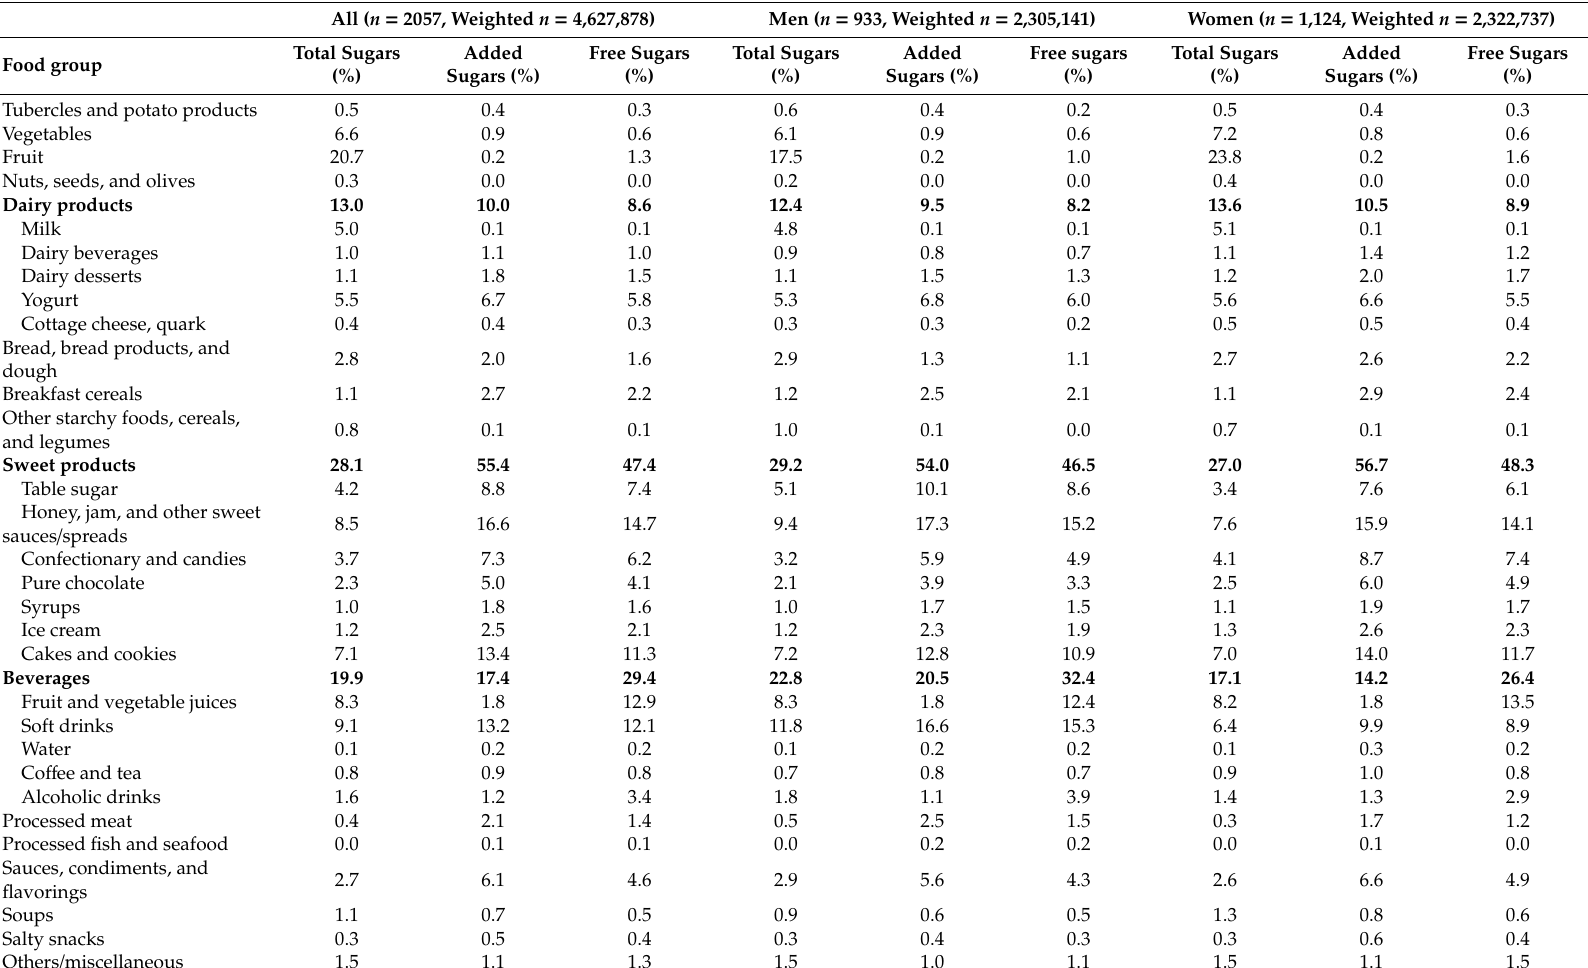
Table 2. Mean contribution by food group for total, added, and free sugars in the entire population and by